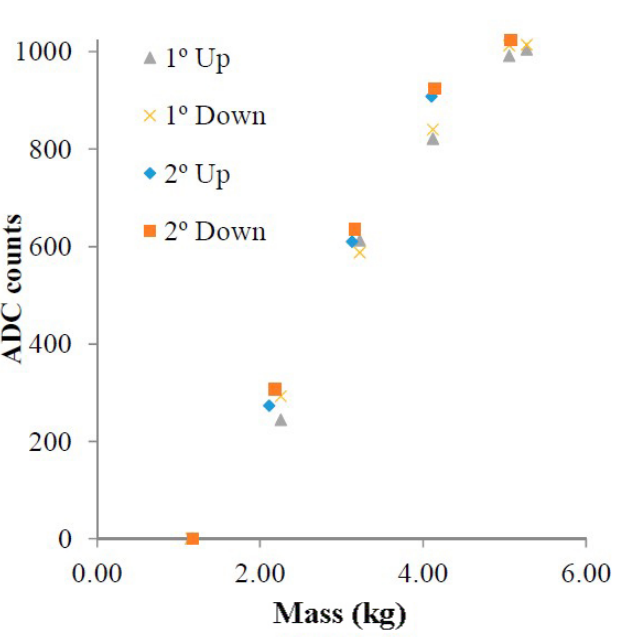
Figure 27. The results of a force sensor showing varying ADC count transmitted by the sensor [42]. X ◦ up/down shows X kg change in weight to observe the sensor’s